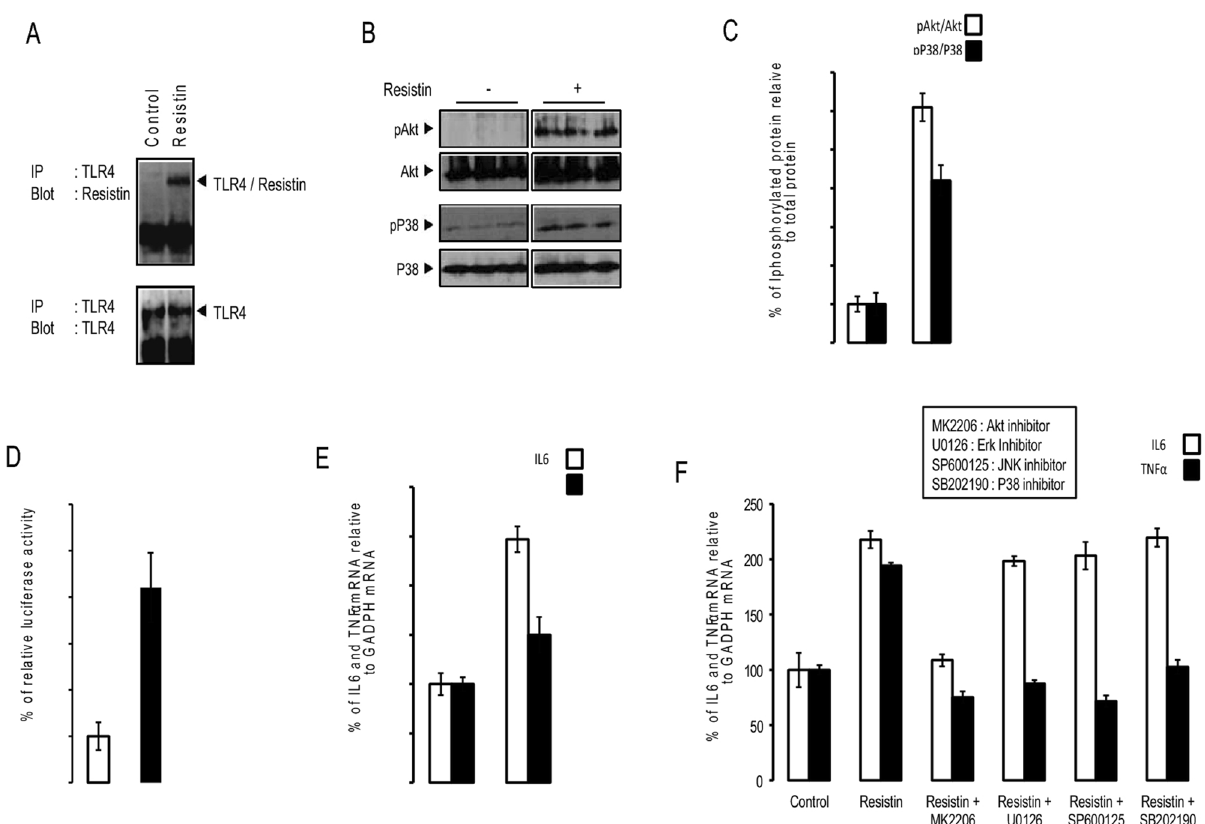
Figure 3. Resistin increased neuroinflammation through its binding to TLR4. (Panel A ) Immunoprecipitation/ Immunoblot (IP/IB) analysis of the direct association of resistin with TLR4 in protein extracts from SH-SY5Y cells treated with resistin (100 ng/ml) for 16 h in the presence or absence of the cross-linker agent BS3, the shown blots are from the same membrane but blotted with different antibodies following immunoprecipitation with anti-TLR4 antibody. (Panel B , C ) SH-SY5Y cells were treated with or without resistin and then Akt and p38 MAP kinase phosphorylation measured by Western blots using adequate antibodies and the presented blots was from the same membrane but blotted successively with different antibodies, the band densities were quantified and expressed as phosphorylated/total proteins. Data were presented as means ± SEM (n = 3), * and *** denoted significant differences vs control at p < 0.05 and p < 0.0005, respectively. (Panel D ) human SH-SY5Y neuroblastoma cells stably transfected with NF-κB luciferase reporter gene were treated resistin and relative luciferase activity determined. (Panel F ) Human SH-SY5Y neuroblastoma cells were treated with resistin in the presence or absence of Akt, Erk, JNK or p38 MAP kinase inhibitors, and then IL6 and TNFα expression was determined using specific primers for these two genes, and normalized using GAPDH. Data were presented as means ± SEM (n = 3). Columns marked by different letter differ (with or without asterix concerns TNFα or IL6, respectively) significantly (p < 0.05). For other panels, data were presented as means ± SEM (n = 3), * and *** denoted significant differences at p < 0.05 and p < 0.005, respectively. (Panel E ) Human SH-SY5Y neuroblastoma cells were treated with resistin or placebo and then IL6 and TNFα expression was determined using adequate primers, and normalized using GAPDH. Data were presented as means ± SEM (n = 3), * and *** denoted significant differences at p < 0.05 and p < 0.001, respectively.